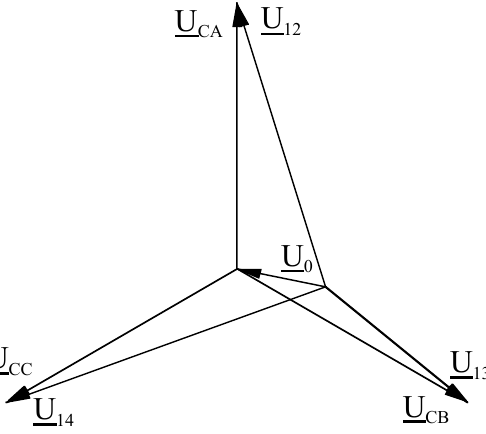
Figure 6. Voltage vector system for the diagram in Figure 5.